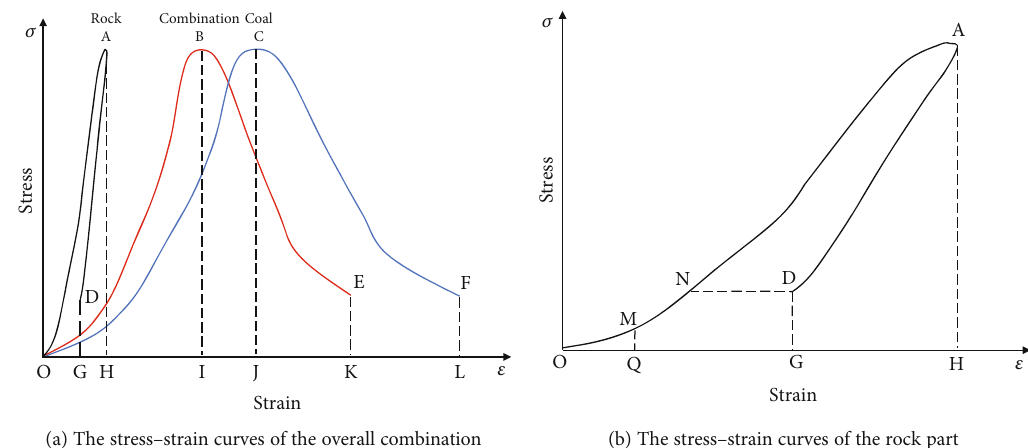
Figure 11: The stress – strain curves of the rock part and the overall combination sample of the coal – rock combination sample structure under uniaxial compression until its failure. Table 3: The calculation results of each research